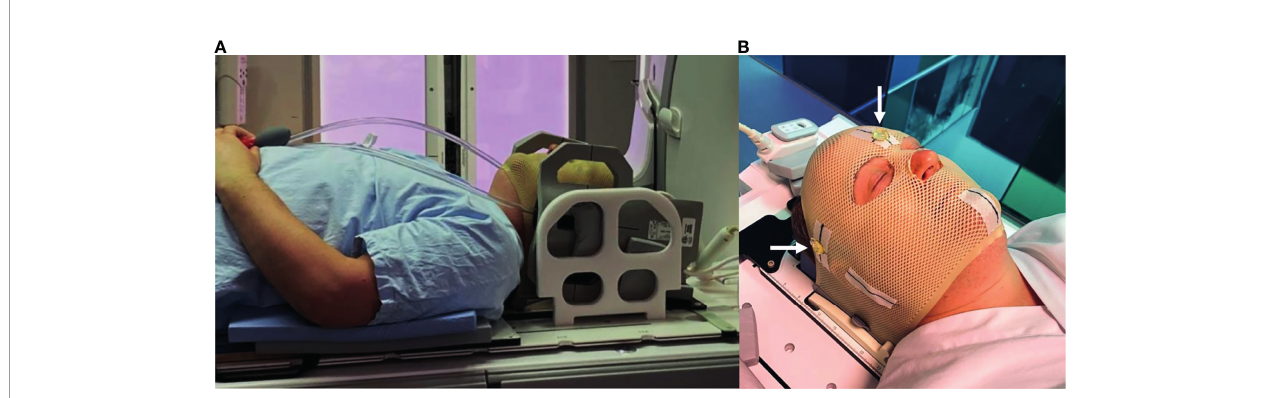
FIGURE 1 | (A) RT-setup of patient in three-point fi xation mask scanned on a fl at tabletop with 6-channel receiver fl ex coils (left and right) combined with an 8- channel posterior array (under the fl at tabletop). (B) Fixation mask with liquid markers front, left and right, indicated by the white